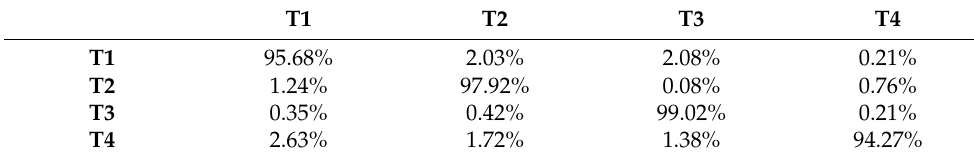
Table 3. Tone confusion matrix context-free words in AWGN-corrupted spoken sentences [108].